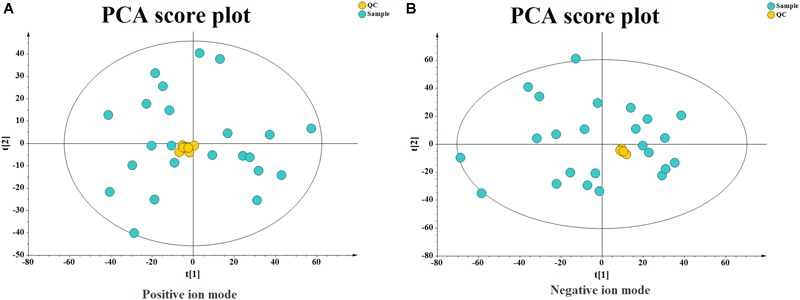
Principal Component Analysis (PCA) Score plot of quality control (QC) Samples. (A) At positive ion mode. (B) At negative ion mode.